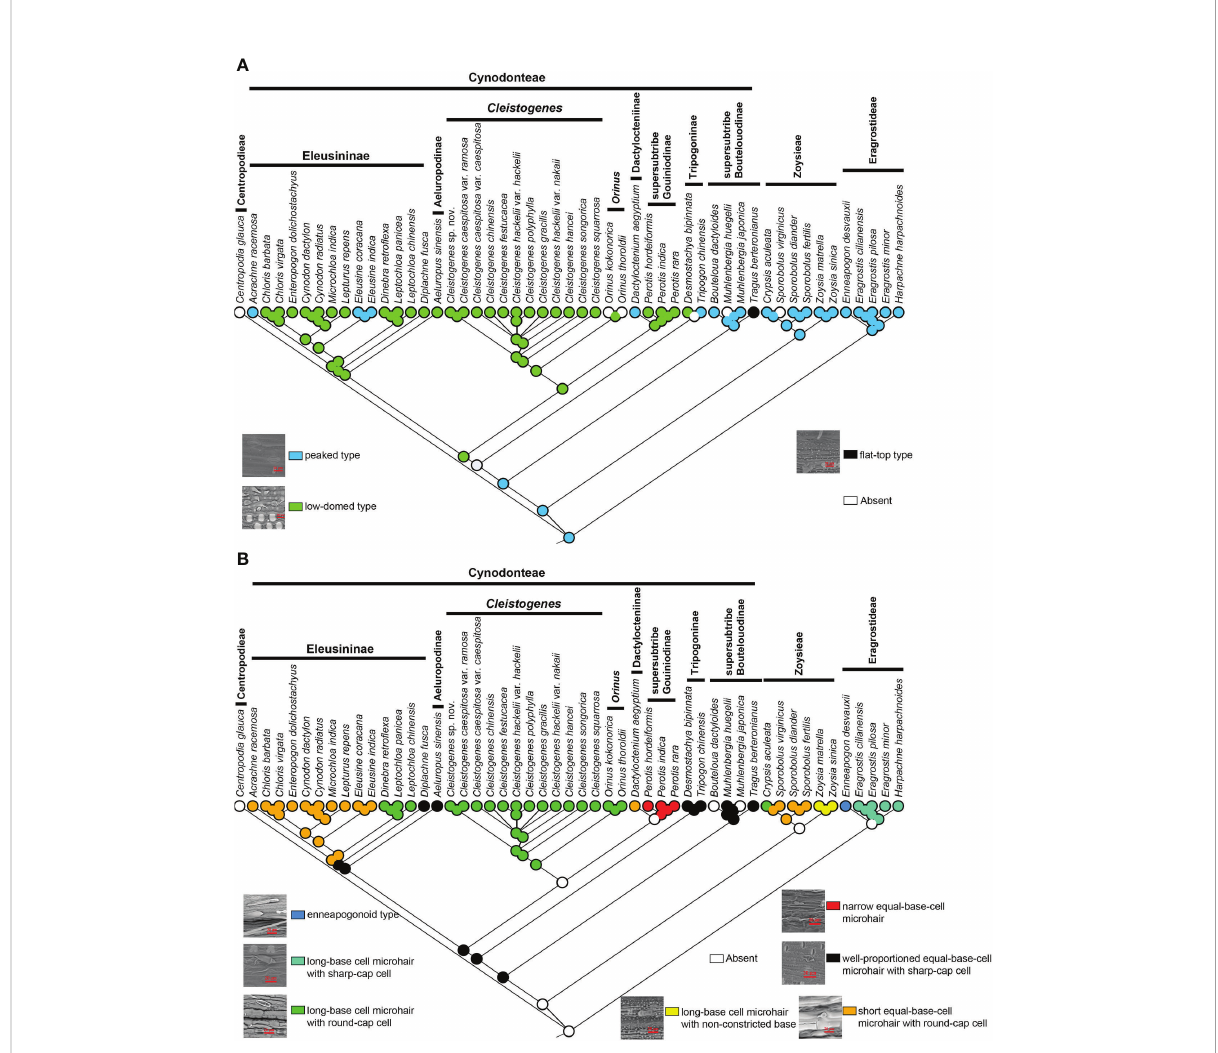
FIGURE 5 Ancestral state reconstruction of Chloridoideae: (A) stomatal subsidiary cell shape; (B) microhair type. The differently coloured spots at the nodes indicate the different character